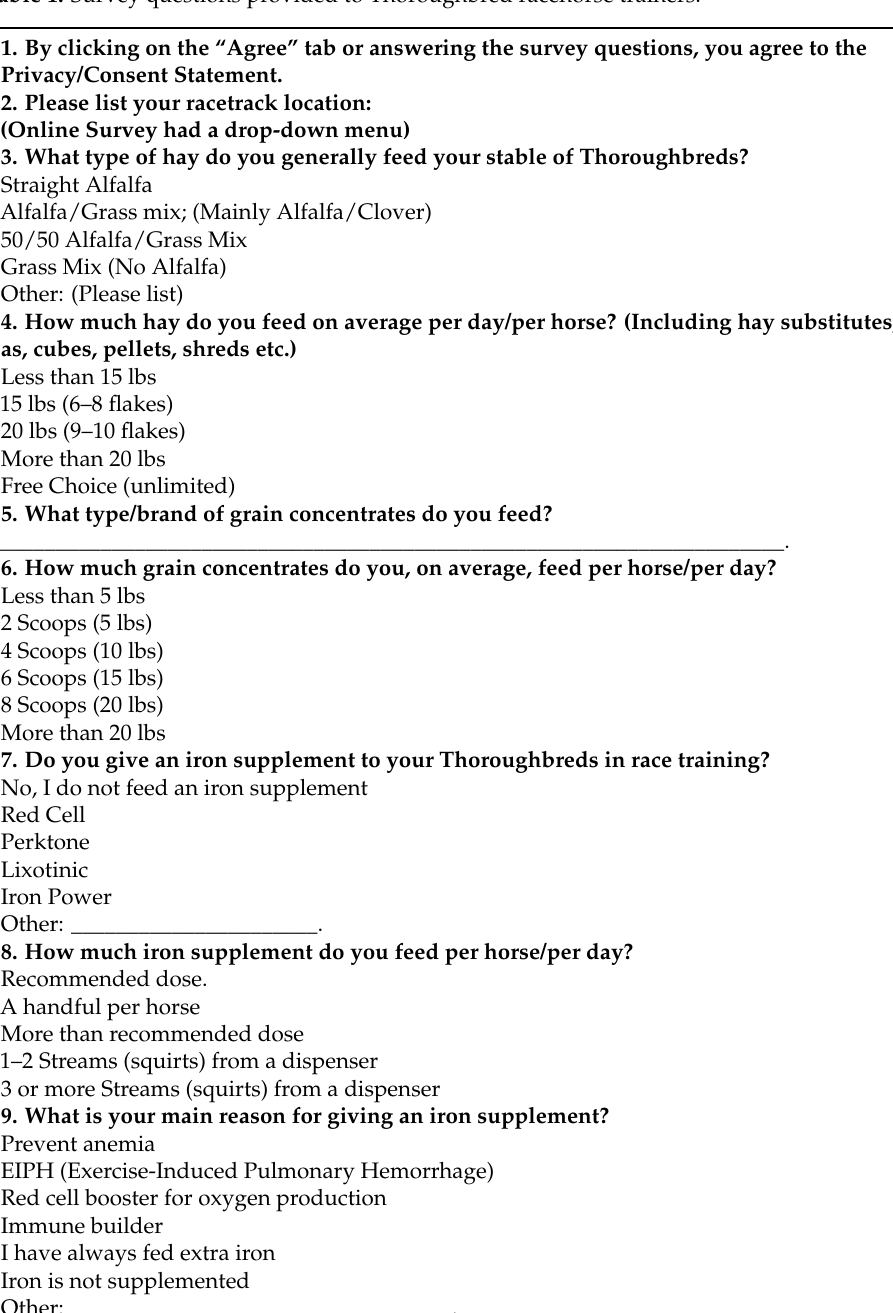
Table 1. Survey questions provided to Thoroughbred racehorse